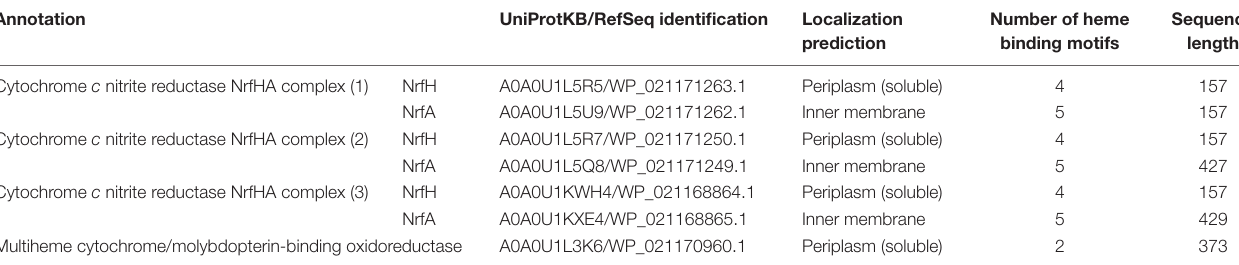
TABLE 2 | C -type cytochromes of S. ovata , determined by a survey at UniProt,